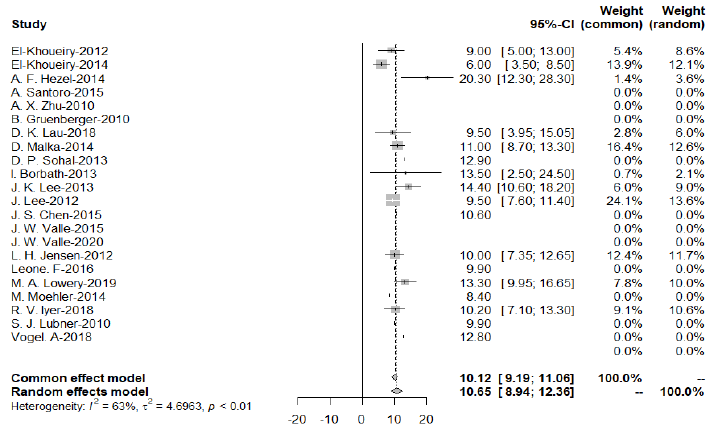
Figure 4. Pooled overall survival with targeted therapy.